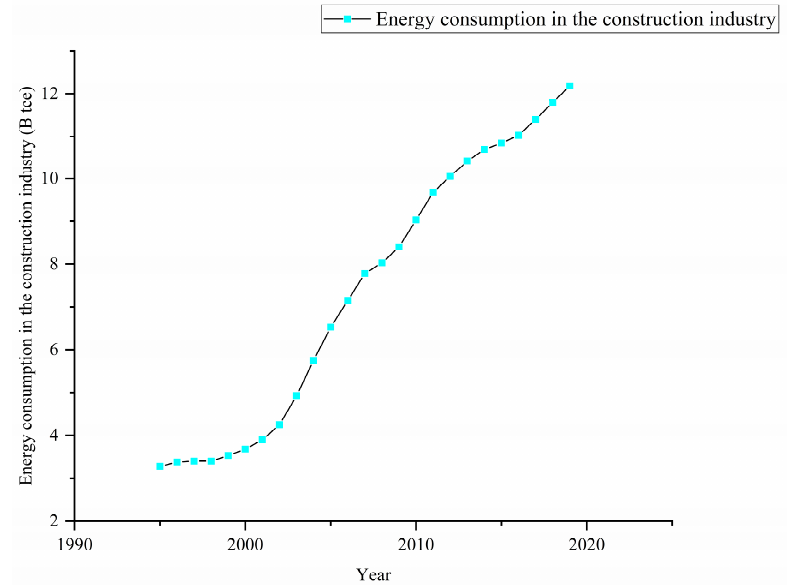
Figure 3. Energy consumption in construction industry (billion tce).